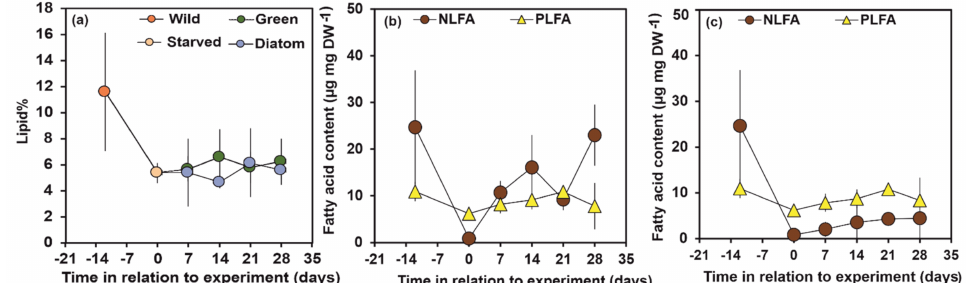
Figure 1. ( a ) Lipid content of Pallaseopsis quadrispinosa in wild (day − 12), starved (day 0) and in green algae ( Acutodesmus sp.) and diatom ( Diatoma tenuis ) experiments. Day refers to the age of initial wild-caught amphipods ( − 12) in relation to the start (day 0, starved 12 days) of the feeding experiment. Total NLFA and PLFA content ( b ) in green algae ( Acutodesmus sp.) and ( c ) diatom ( Diatoma tenuis ) experiments.